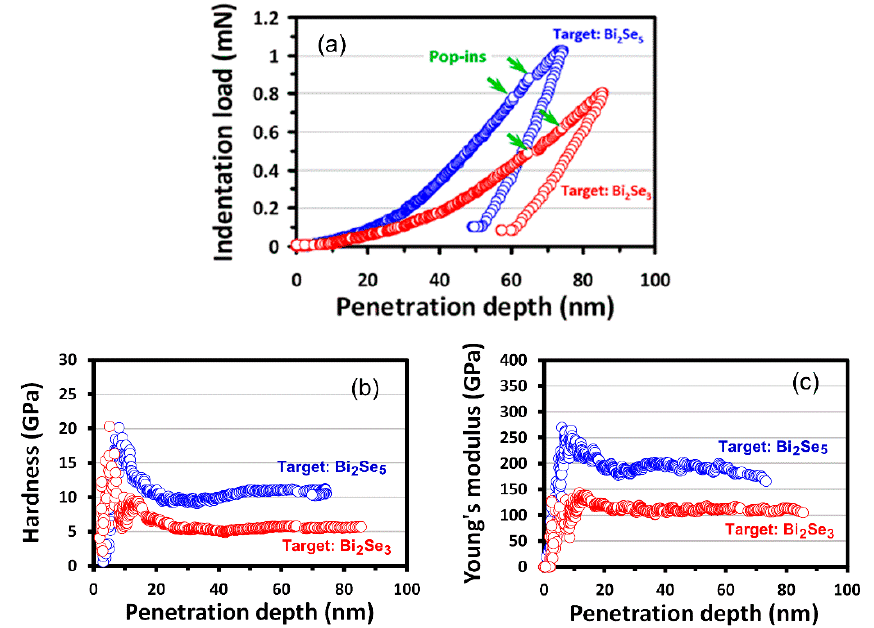
Figure 4. ( a ) The load–displacement curves of Bi 2 Se 3 thin films deposited on InP(111) substrates using two di ff erent target compositions. A clear single “pop-in” behavior is displayed in both curves during loading. ( b ) A hardness—displacement curve and ( c ) a Young’s modulus–displacement curve for a Bi 2 Se 3 thin films deposited using Bi 2 Se 3 and Bi 2 Se 5 targets.